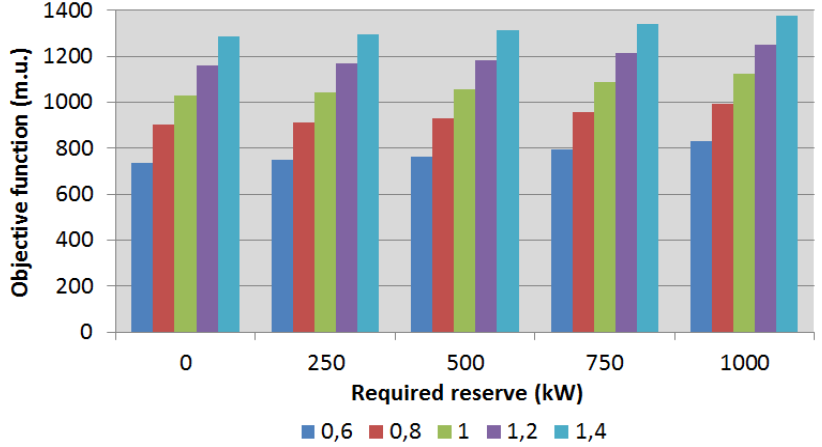
Figure 5. VPP operation in each